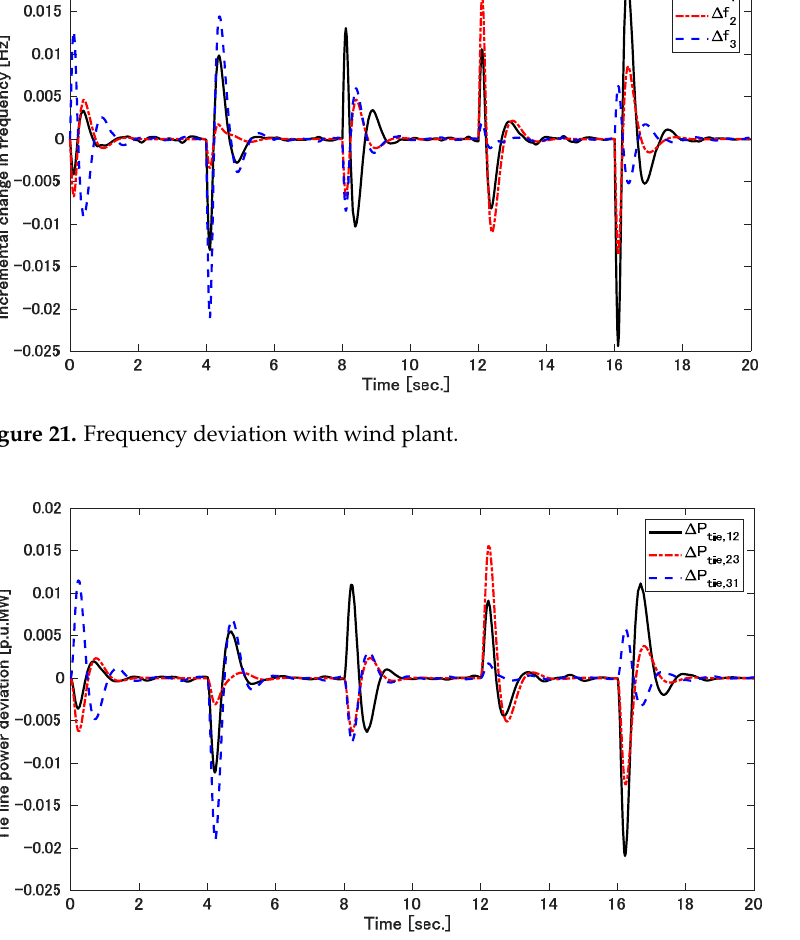
Figure 22. Tie-line power deviation with wind plant.